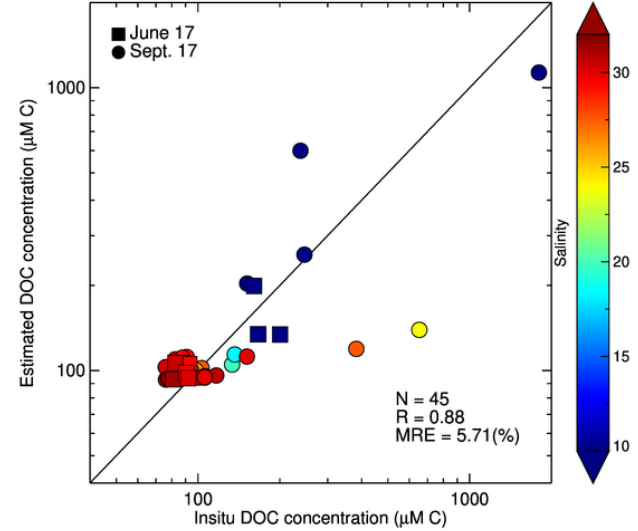
Figure 3. Scatter plot of log scale estimated [DOC] as a function of the direct relationship of log scale in situ [DOC] (N = 45; RMSE = 143.54; MRE = +5.71%). The solid line represents 1:1 direct